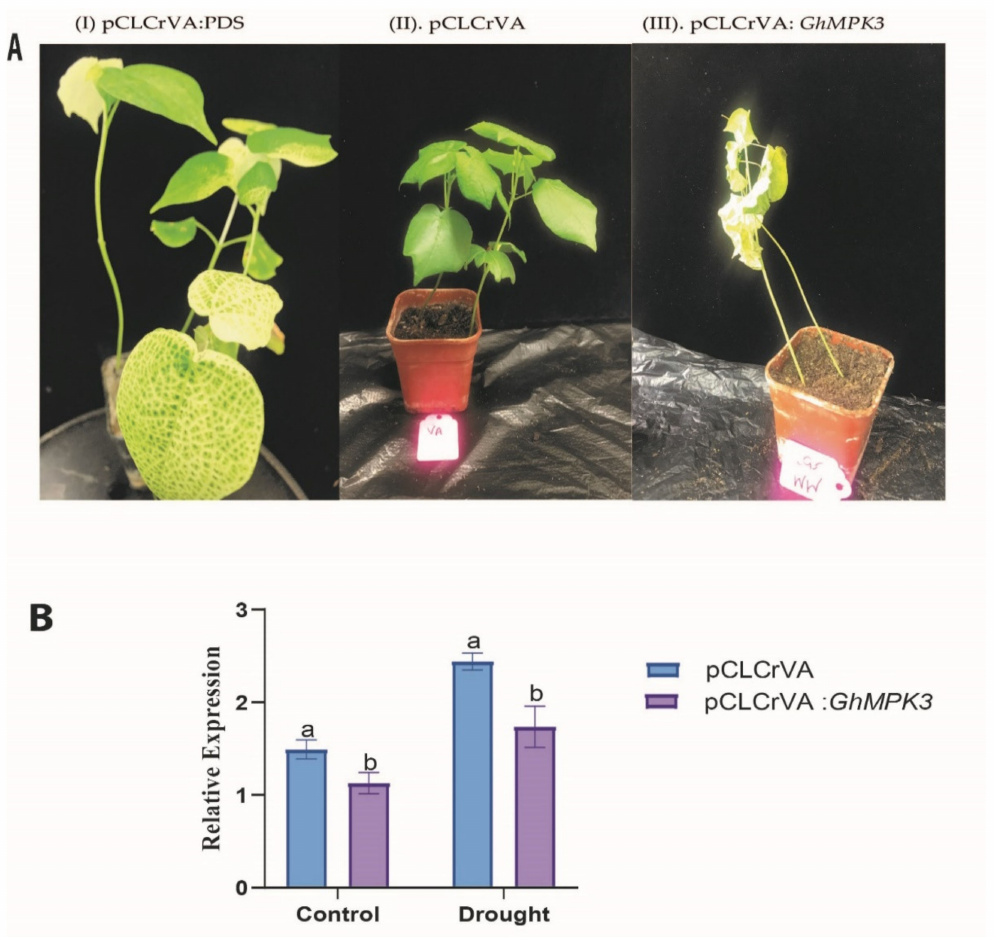
Figure 8. Phenotypic feature of GhMPK3 -silenced plants ( A ) (I) pCLCrVA:PDS (II) pCLCrVA (III) pCLCrVA: GhMPK3 ( B ). GhMPK3’s expression level in empty control and GhMPK3 -silenced plants. Each experiment was conducted three times. The error bar represents the three biological replicate’s standard deviation. The significant differences between VA and GhMPK3 -VIGS plants (ANOVA; p < 0.05) are indicated by different letters